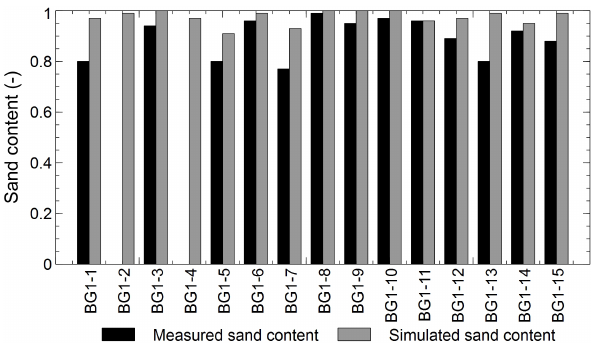
Fig. 14. Observed vs. simulated sediment texture of all layers found inside the analysed